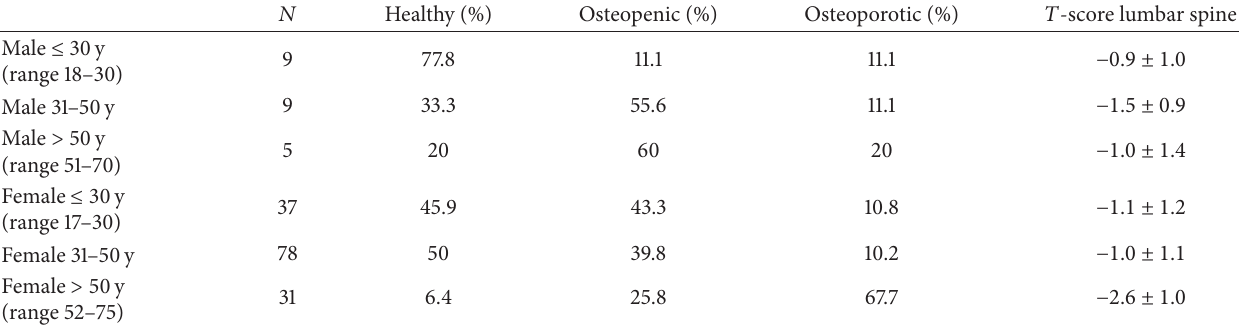
Table 2: Bone mineral density (BMD) at lumbar spine scores according to sex and